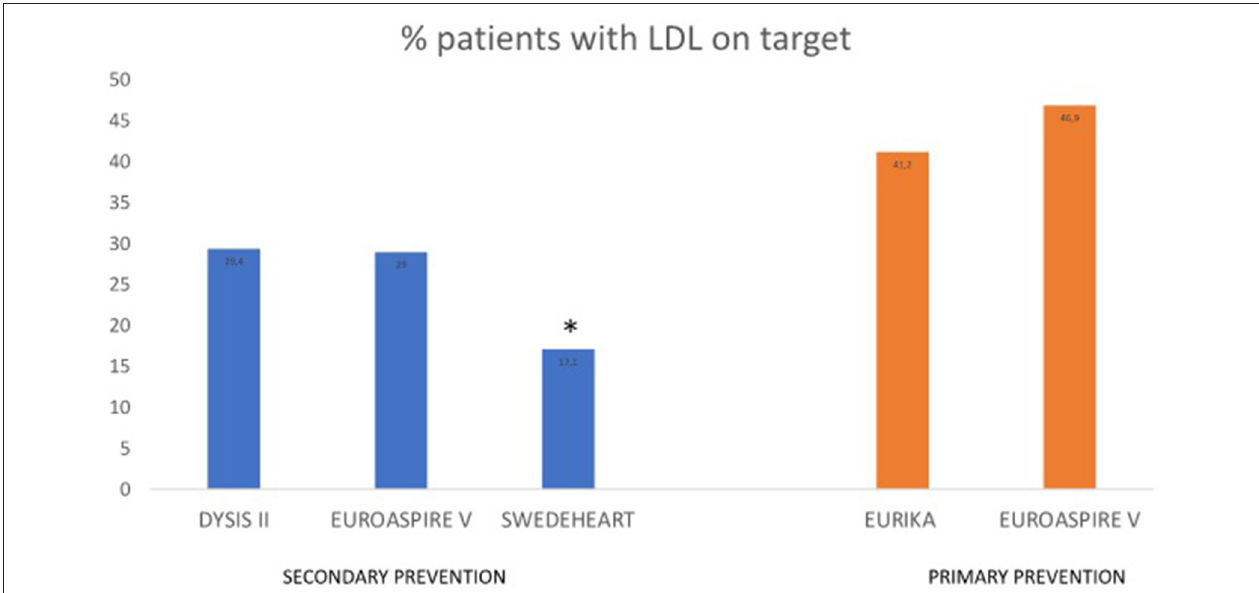
FIGURE 3 | Observational studies assessing LDL-C control in primary and secondary prevention. *LDL-C goal < 55 mg/dL. EURIKA, European Study of Cardiovascular Risk; EUROASPIRE V, European Society of Cardiology survey of secondary prevention of coronary heart disease; DYSIS, Dyslipidemia International Study; SWEDEHEART, the Swedish Health Care Registry on Heart